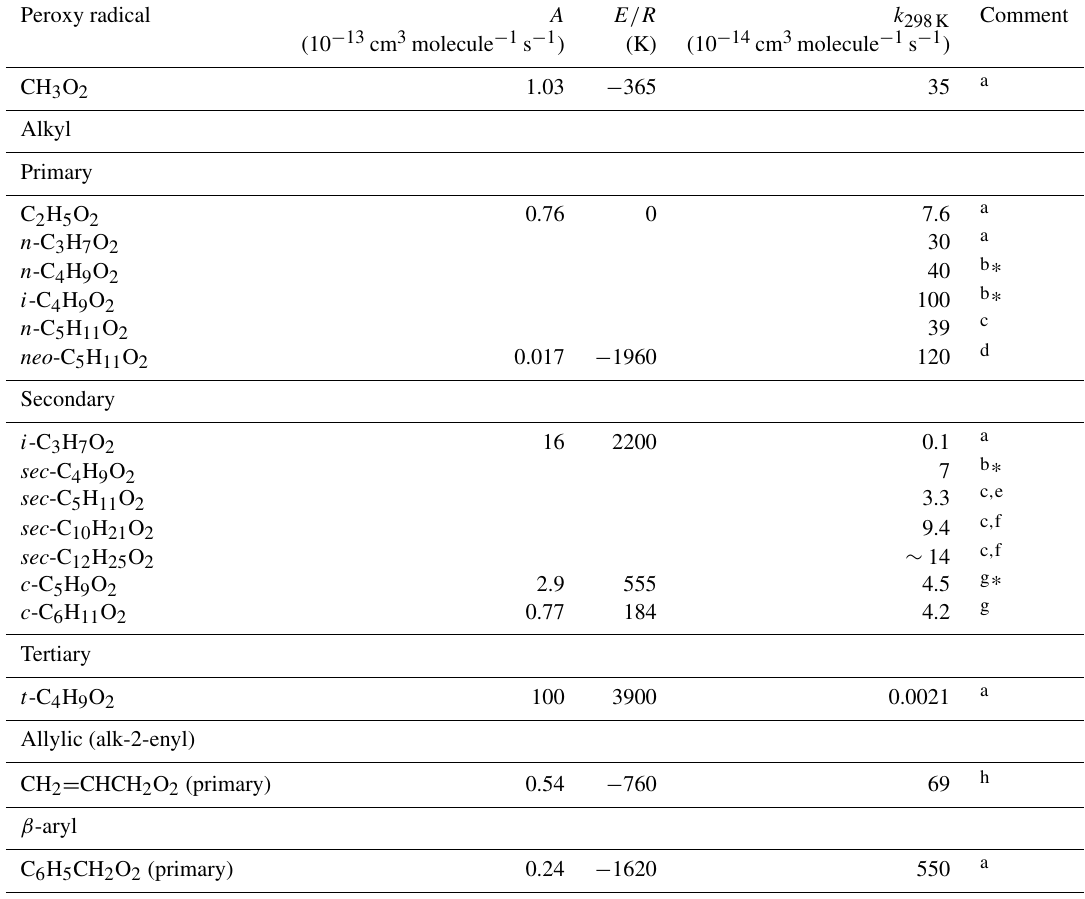
Table 9. Kinetic data for the self-reactions of hydrocarbon peroxy radicals. Where available, the temperature dependence is given by k = A exp ( − E/RT )